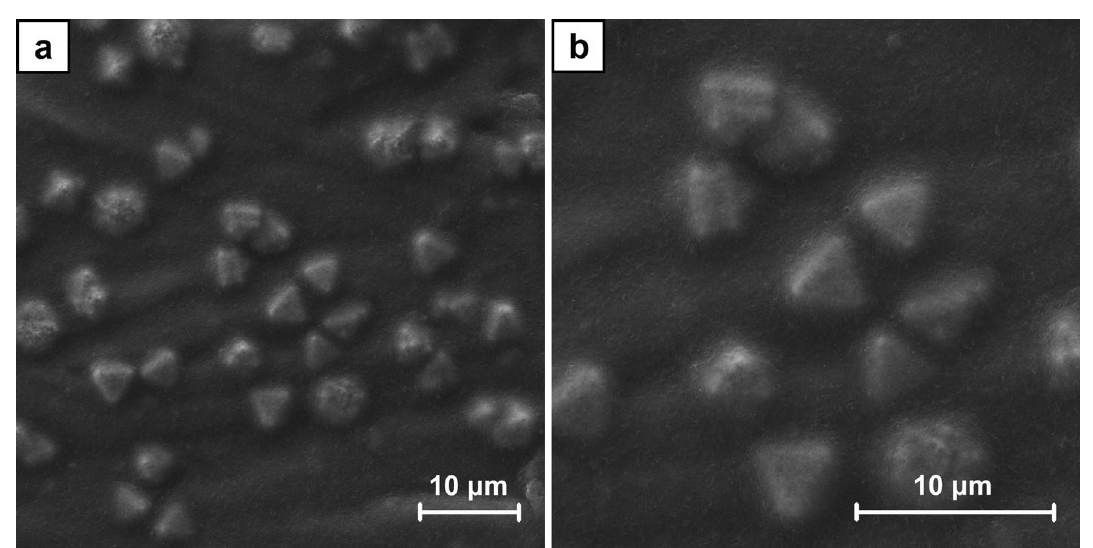
Figure 5. SEM images of the crystals which formed within CNT layer in B6 sample (ECD deposition time of 450 s, CuSO 4 concentration of 100 mM) at the magnification of ×5000 ( a ) and ×10,000 ( b